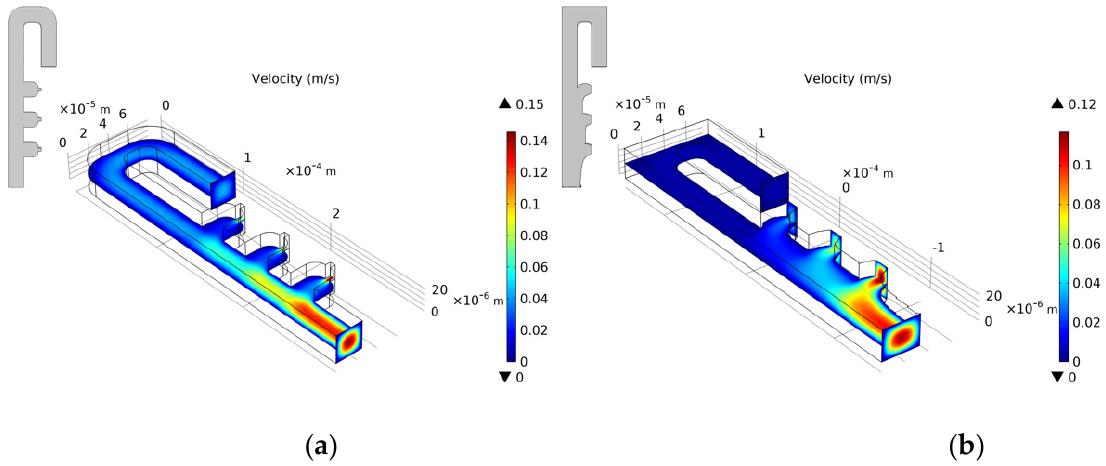
Figure 17. ( a ) The flow field distribution of the optimized structure in [25] and ( b ) the flow field distribution of the opti- mized structure in this paper of single-cell capture model.